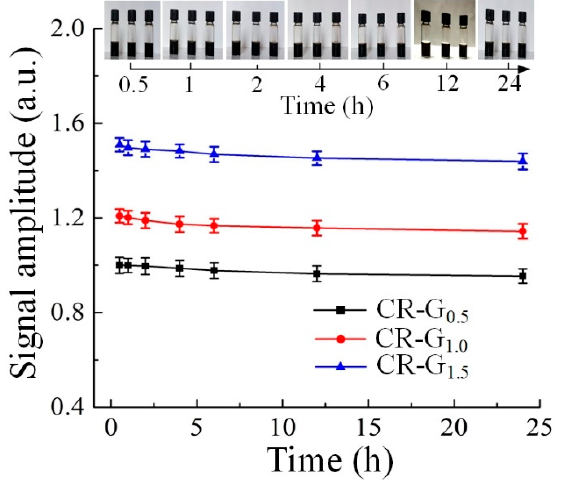
Figure 6. The stability of the chemically-reduced graphene oxide (CR-G) nanomaterials with different degrees of reduction in normal saline.